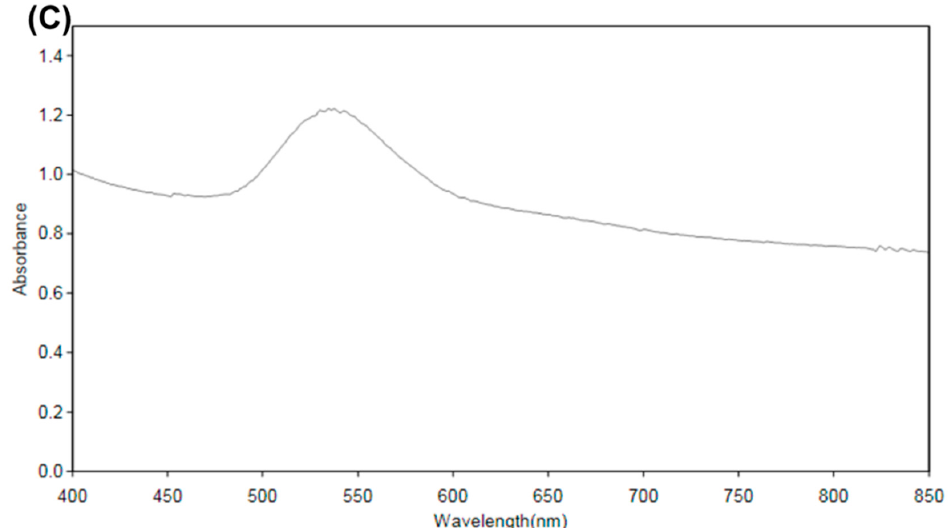
Figure 2. ( A ) TEM image of developed T GNC-DOX (scale: 100 nm). ( B ) Magnified TEM image of T GNC-DOX (scale: 5 nm). ( C ) UV absorption spectrum of T GNC-DOX.